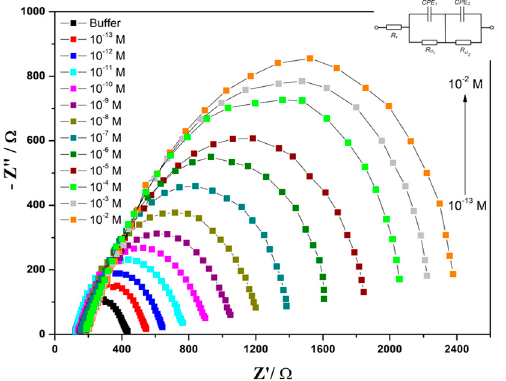
Figure 4. Impedance data in the Nyquist plot format showing up the change of the charge transfer resistances (R ct ) due to the addition of a different concentration of cadmium ions into the electrochemical cell, which is connected with a disposable screen-printed electrode modified with a ligand/nanocellulose nanocomposite. (The equivalent circuit, inserted figure, was used for quantitative analysis [44].